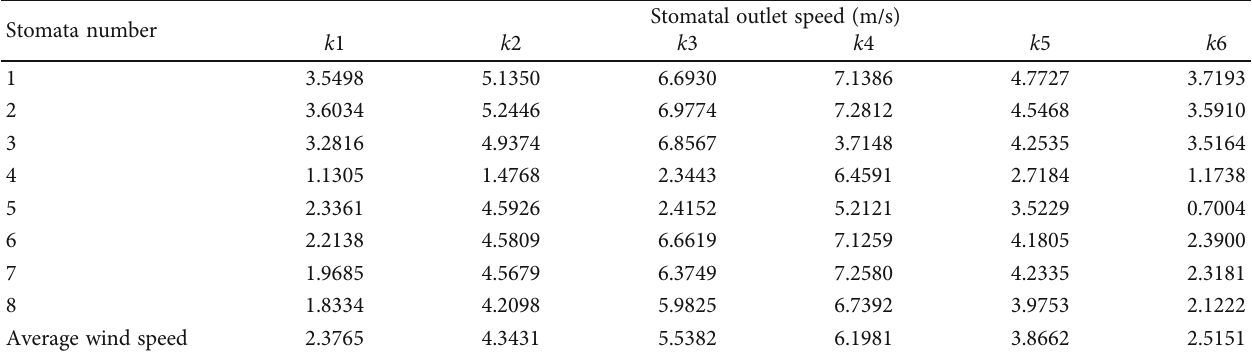
Table 1: Datasheet of transverse type (10 m 3